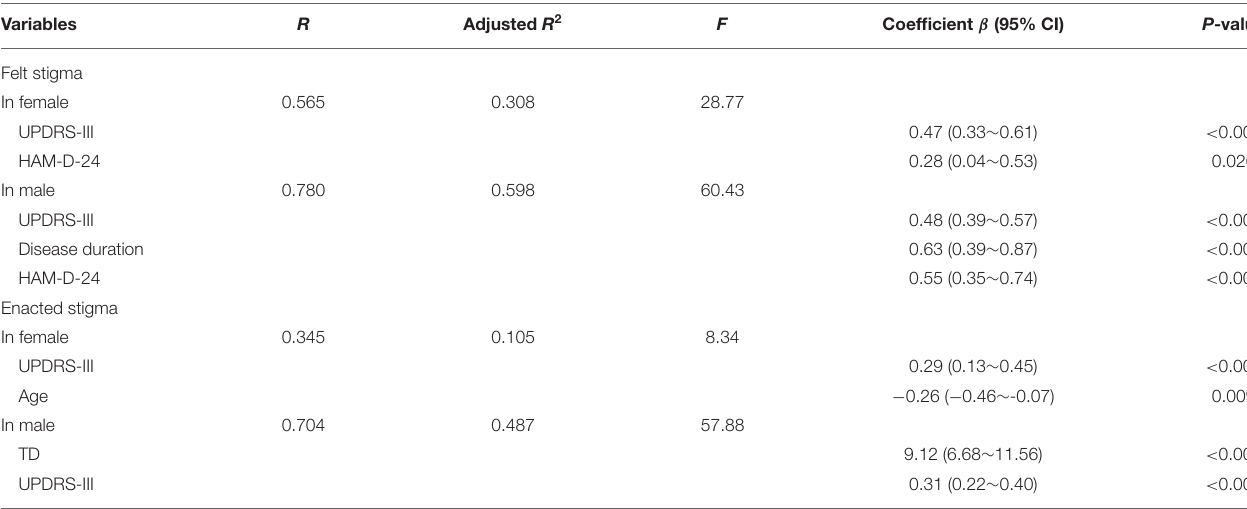
TABLE 3 | Multivariate linear regression model of factors associated with felt and enacted SSCI according to